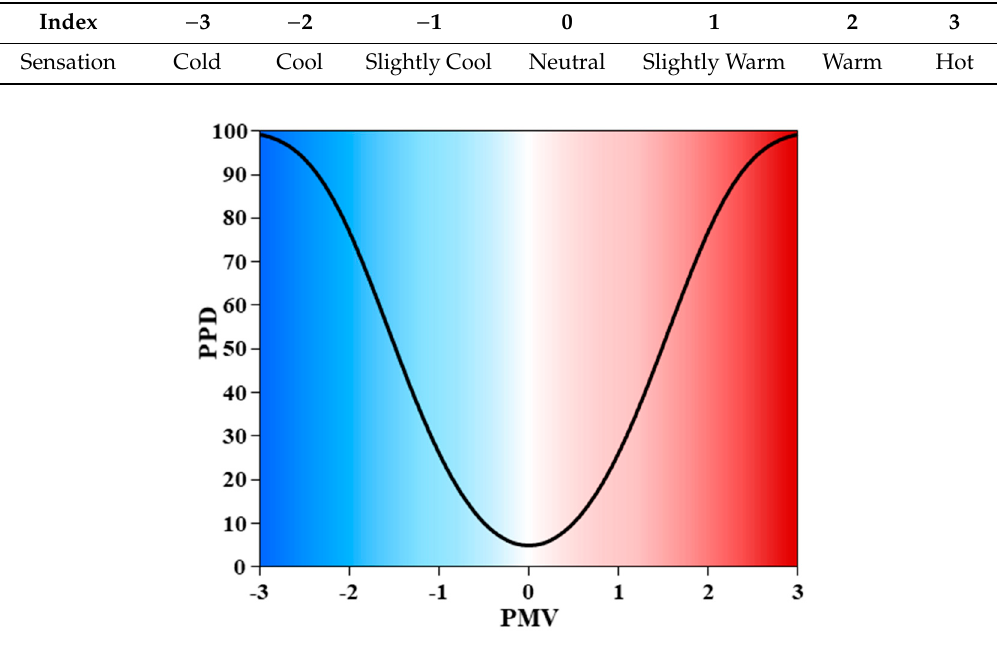
Figure 1. Percentage of dissatisfied (PPD) as a function of PMV.